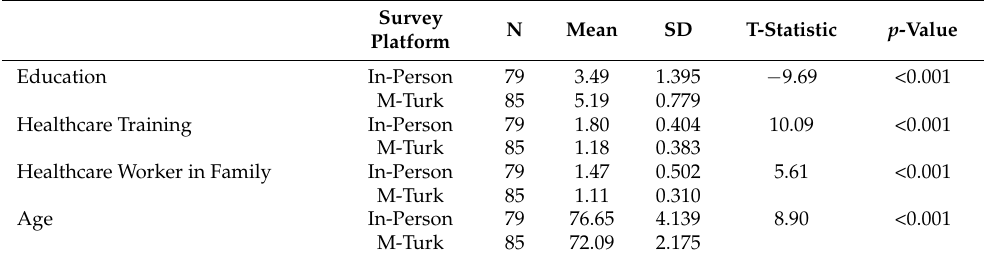
Table 1. Mean Differences Between Groups.